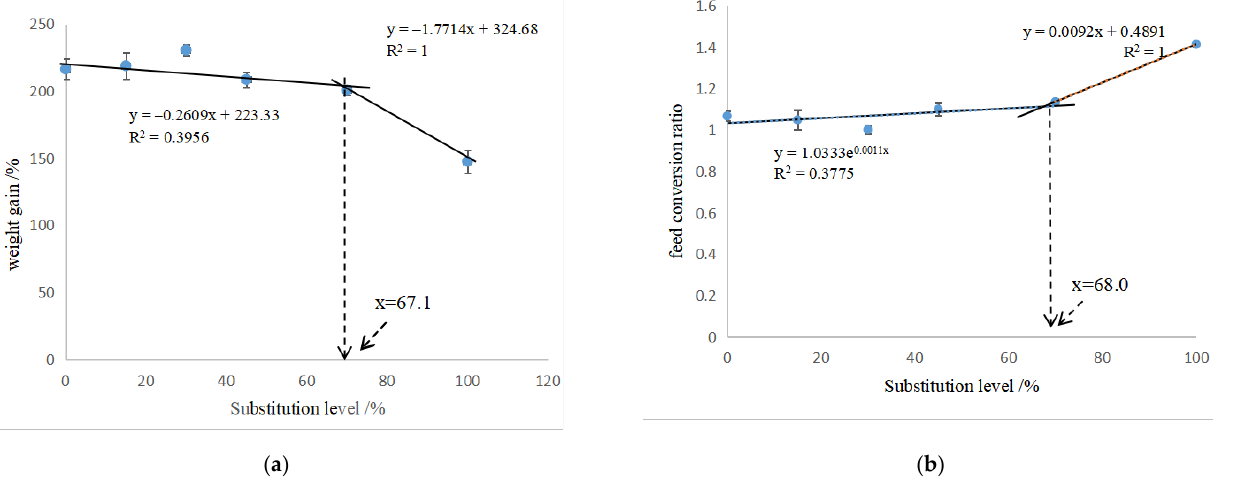
Figure 1. Broken-line analysis of weight gain ( a ) and feed conversion ratio ( b ) against substituted ratio of fish meal with CAP.